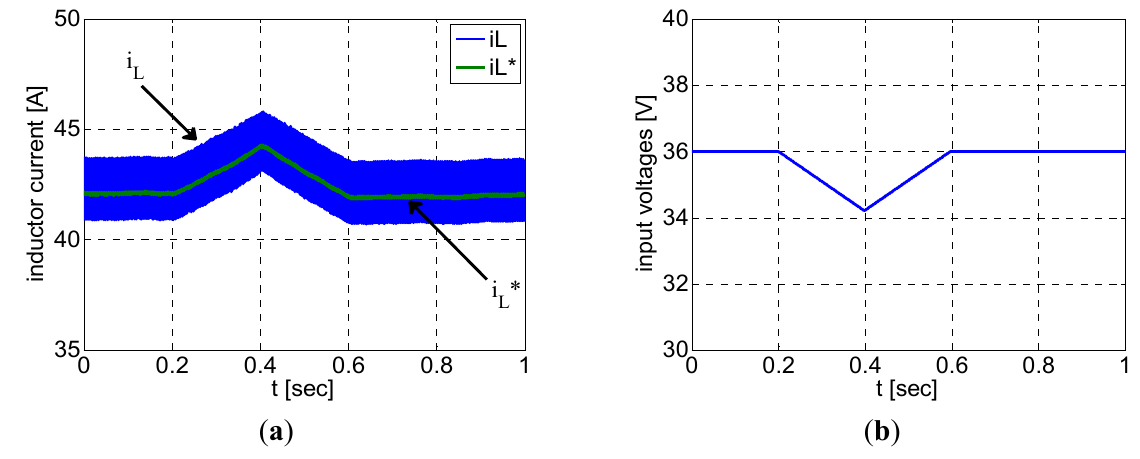
Figure 12. Input voltage variation results: ( a ) input voltage; ( b ) inductor current.